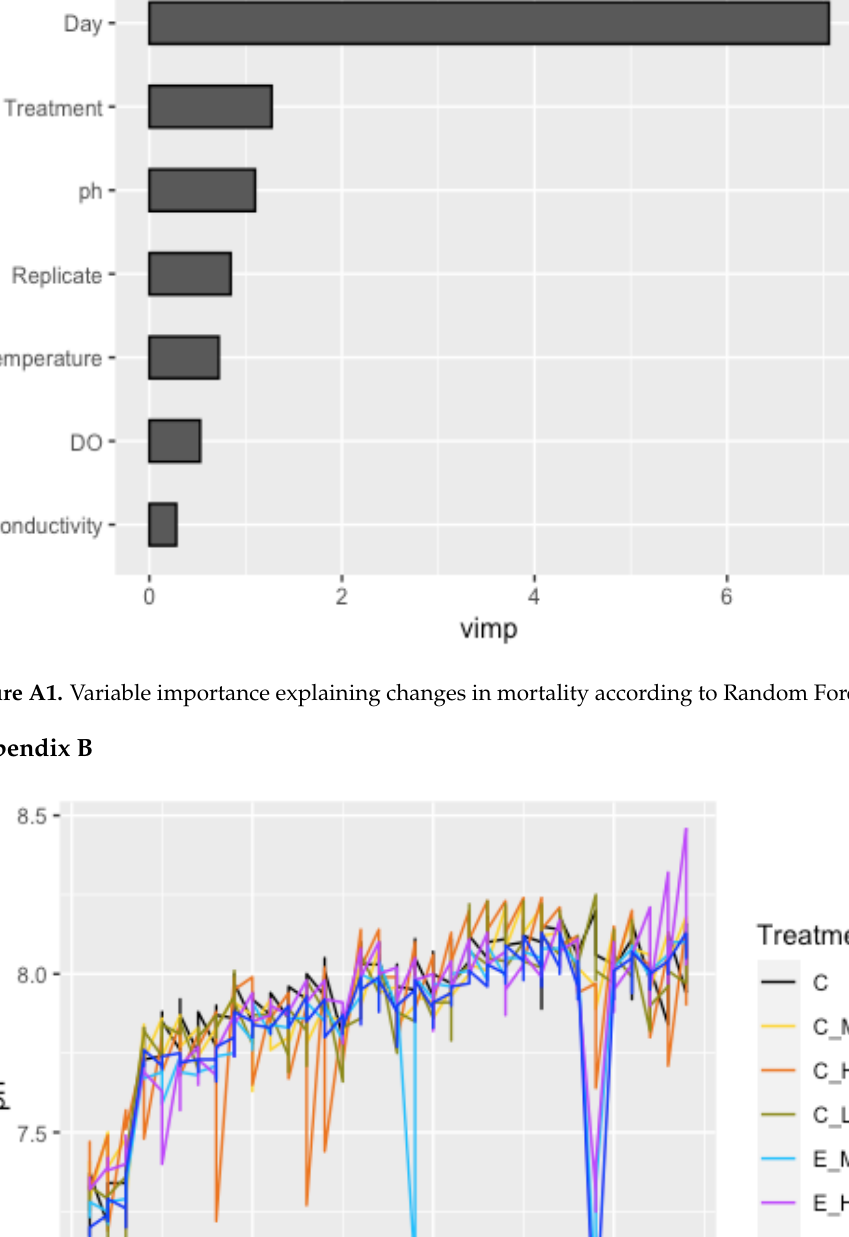
Figure A3. Variable importance explaining changes in leaf decomposition according to Random Forests. References 1.